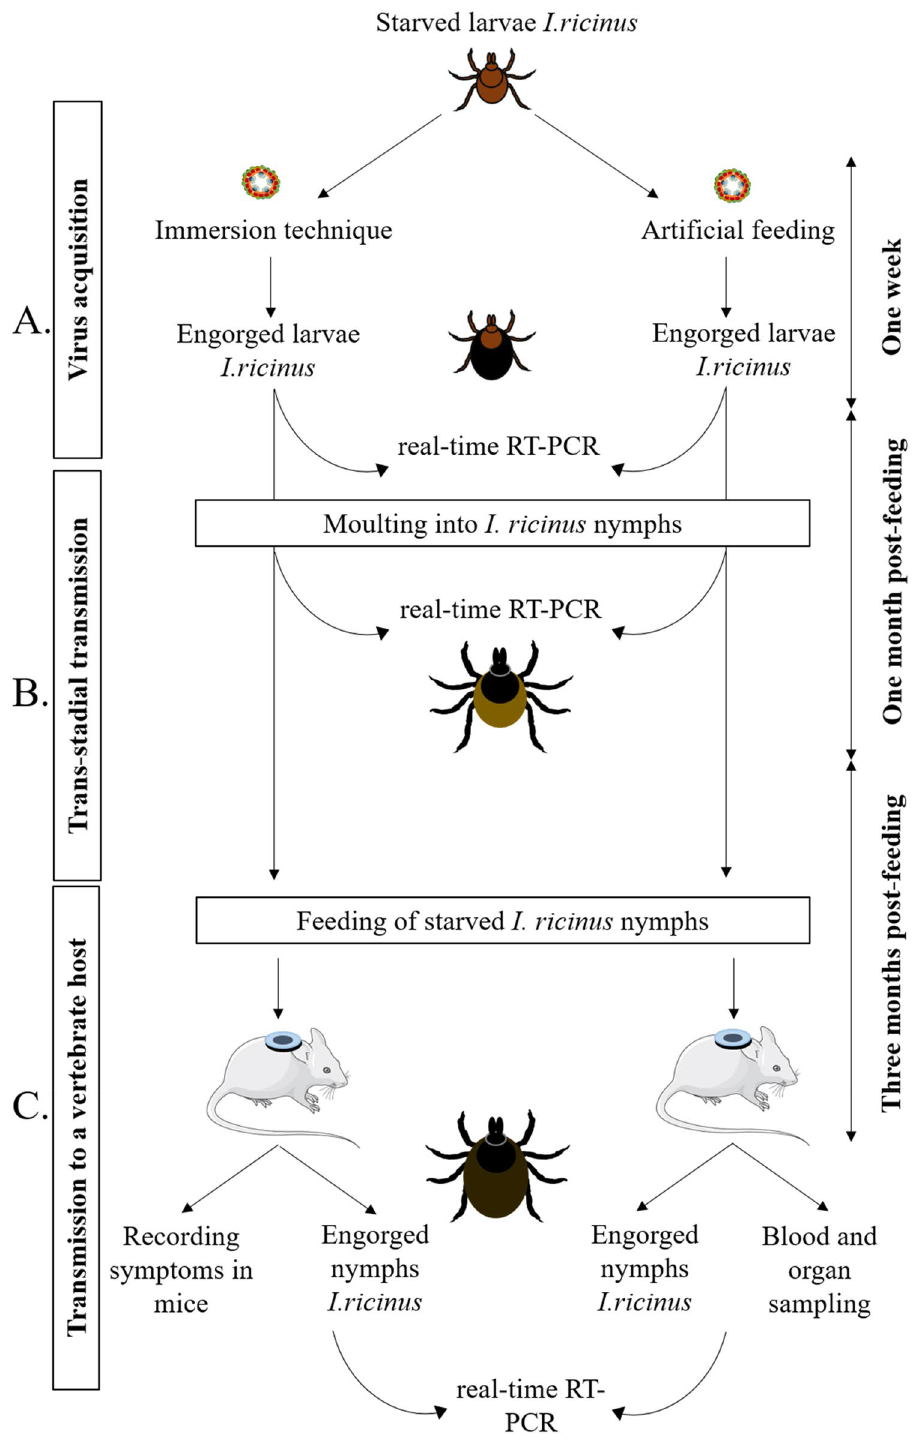
Figure 2. Schematic representation of the experimental design for assessing vector competence of ticks for pathogens through immersion technique and artificial feeding. ( A ) pathogen acquisition, ( B ) trans-stadial pathogen transmission and ( C ) transmission of the pathogen to a vertebrate host. Ticks were allowed to feed to repletion and harvested immediately after feeding. Real-time RT-PCR is performed to specifically detect the pathogen’s RNA in ticks and mice at different steps of the